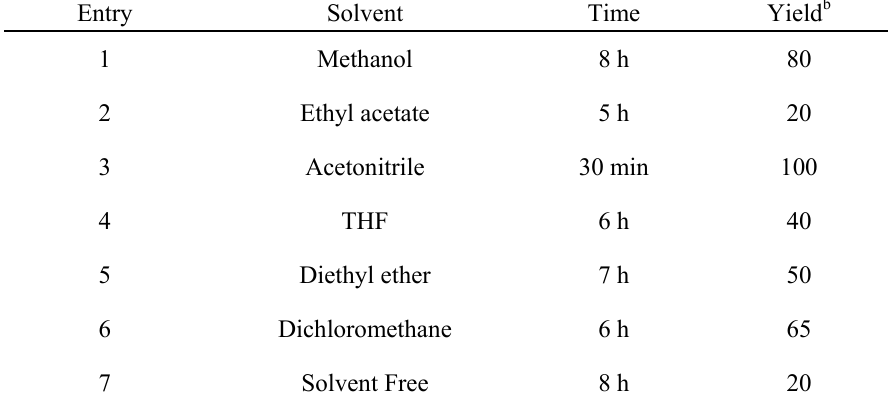
Table 1. Conversion of (1) to its corresponding thioacetal in different solvents and under solvent-free conditions in the presence of BABOT at rt